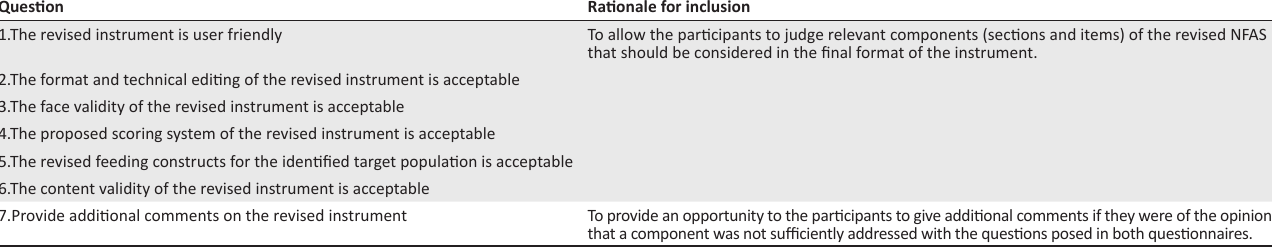
TABLE 3: Content and rationale for expert panel questionnaire 2. Question Rationale for inclusion